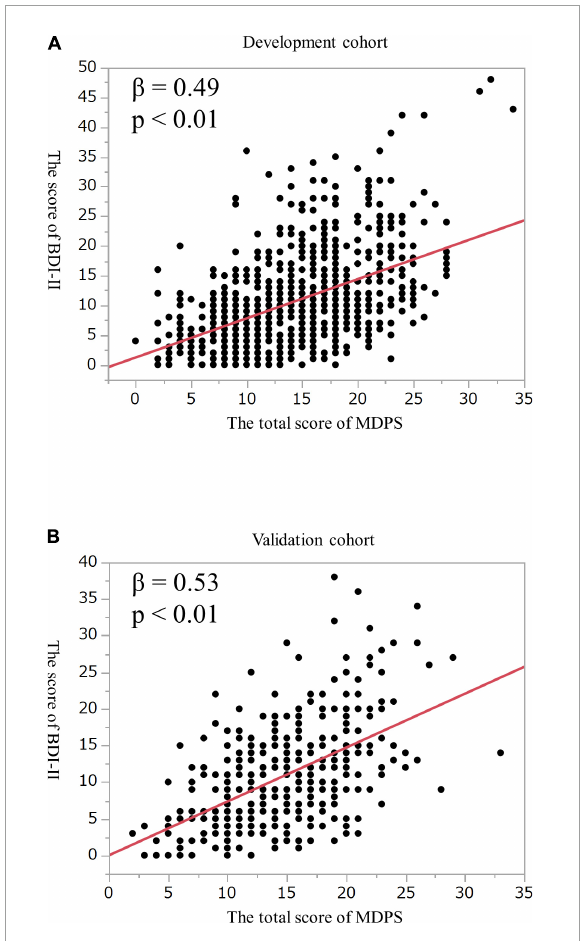
FIGURE2 Correlation between the score of the MDPS and the BDI-II in (A) the development cohort and (B) the validation cohort. MDPS, multidimensional physical score; BDI, beck depression